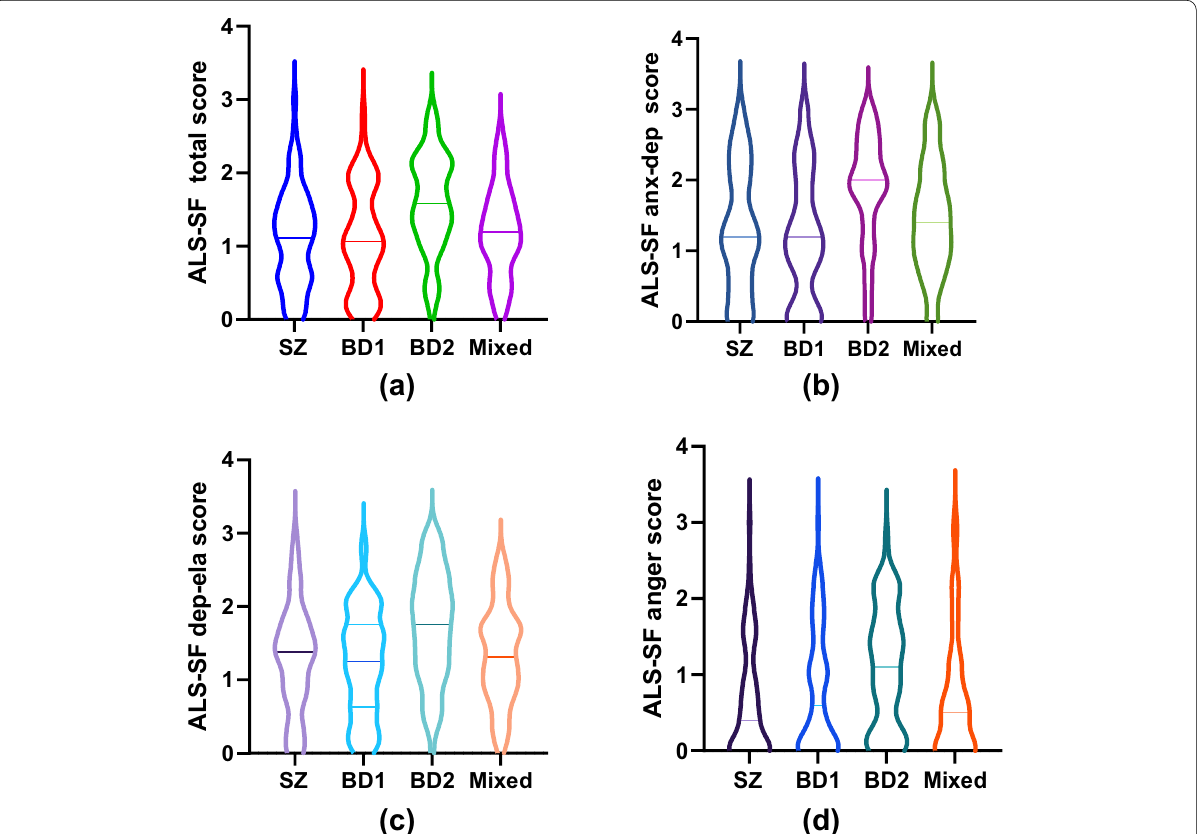
Fig. 2 a – d ALS-SF score distribution: a ALS-SF total score, b anxiety-depression dimension, c depression-elation dimension, d anger dimension. SZ schizophrenia, BD bipolar disorder, ALS-SF affective lability scale short form, anx-dep anxiety-depression dimension, dep-ela depression-elation